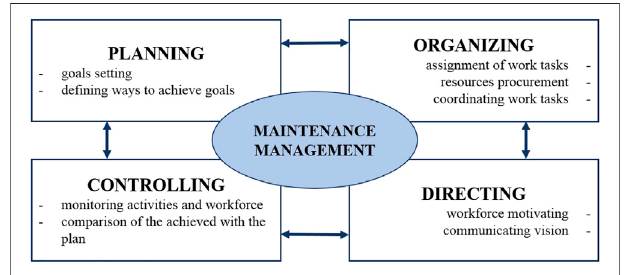
FIGURE 1 | Maintenance management model (adapted from Ogunoh et al., 2018).